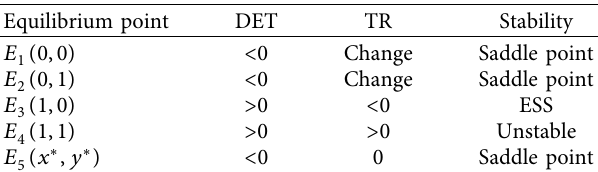
Table 6: Stability analysis of strategy system ( d ) of the government and enterprise.